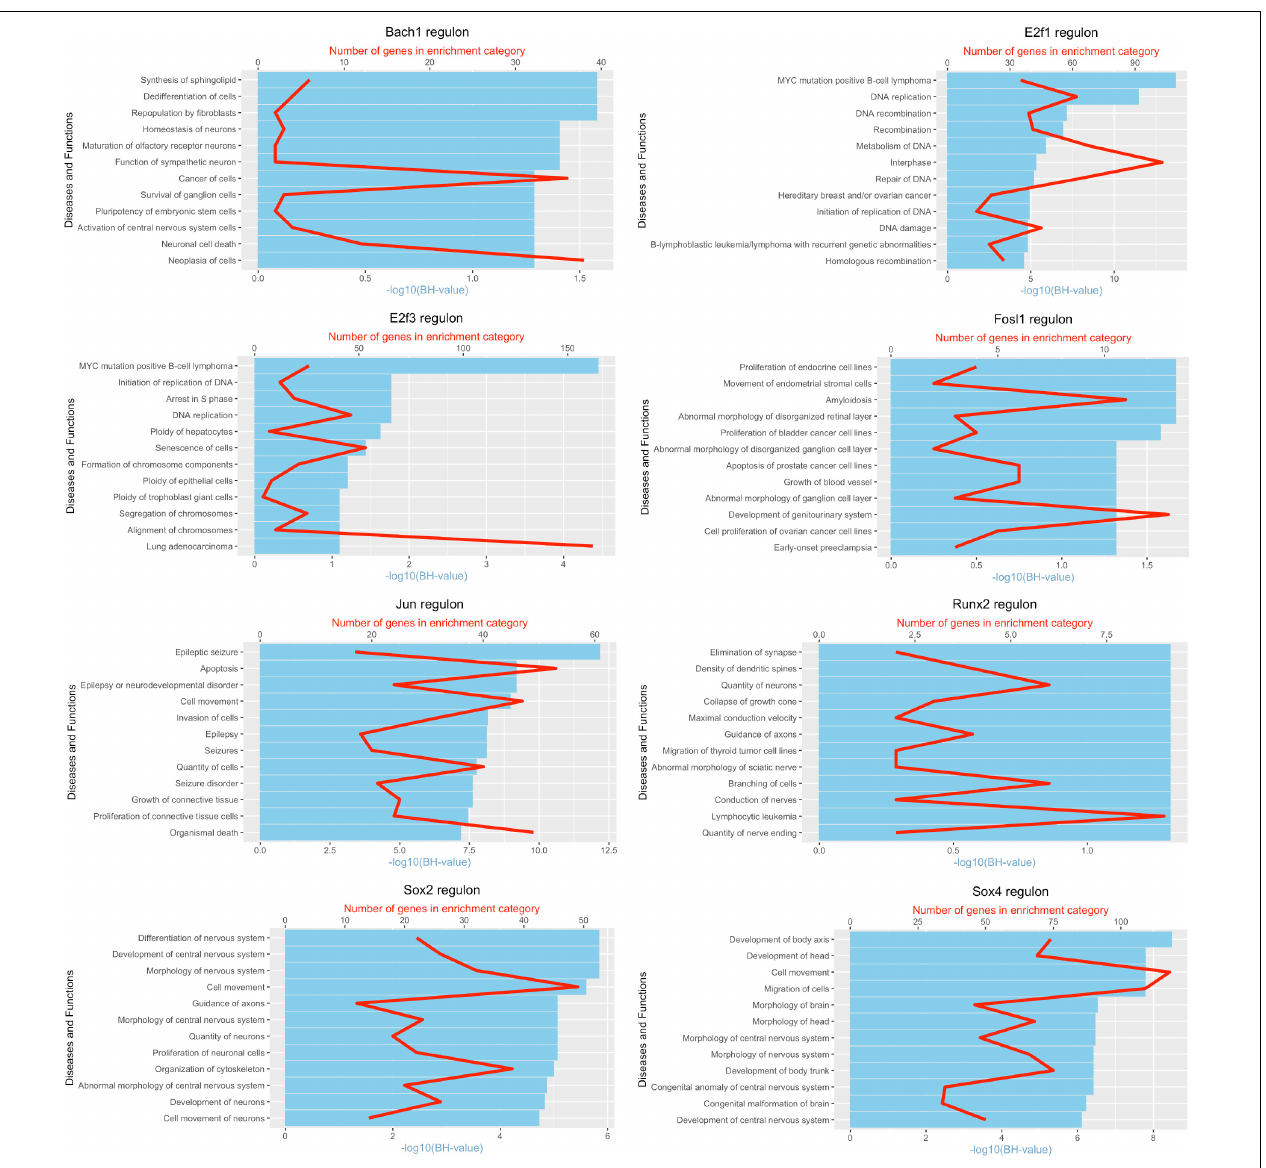
FIGURE 10 | Pathway and functional enrichment analysis of Bach1, E2f1, E2f3, Fosl1, Jun, Runx2, Sox2, and Sox4 in Schwann cells at day 3